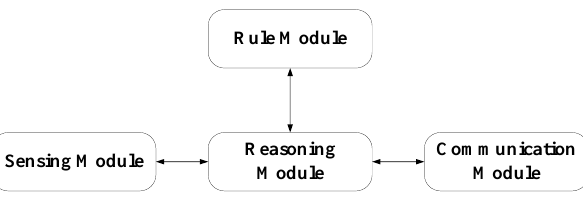
Figure 1. The basic structure of the agent.